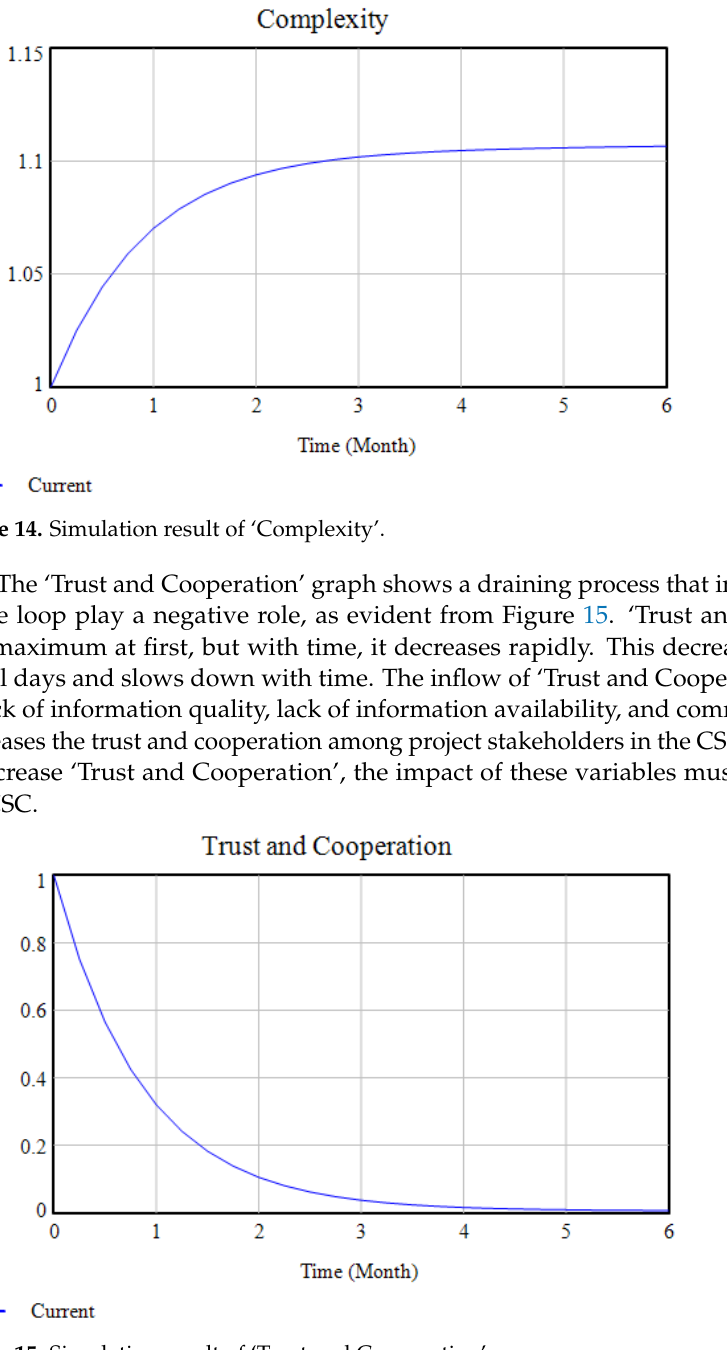
Figure 16. Simulation result of ‘Top Management Support’. 4.4. Model Validation An SD model addresses the problem and provides a solution for complexity in vari- ous systems and processes. In order to put confidence in a simulation model so that it shows the right behavior for the right reasons, it must be validated using different valida- tion tests [62]. Model validation is a continuous and repetitive process. Therefore, the model must be validated from the beginning of its development until its completion. The same concept was followed in this study. Furthermore, the model and its results were presented to different construction in- dustry professionals to capture their expert opinion for its validation. The model was